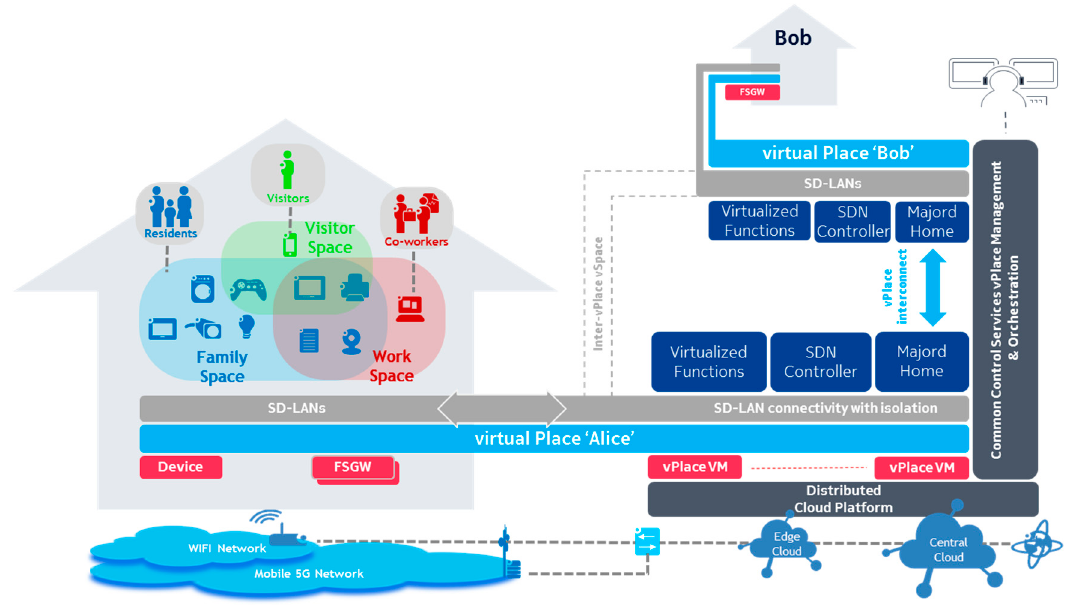
Figure 3. Multiple vPlaces running in the Future Spaces distributed cloud platform.